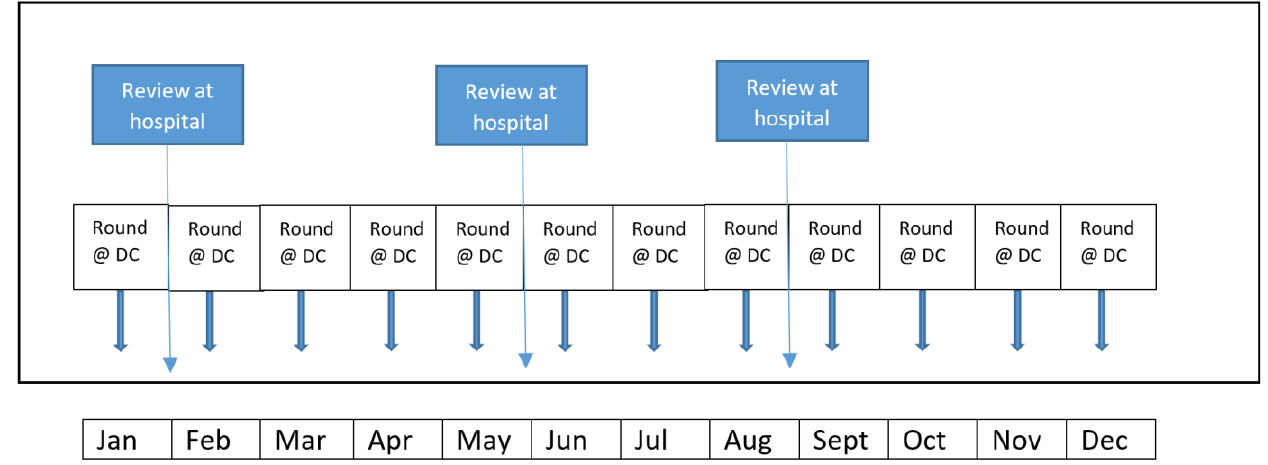
Figure 1. Structure of review at the dialysis unit before the COVID-19 pandemic.